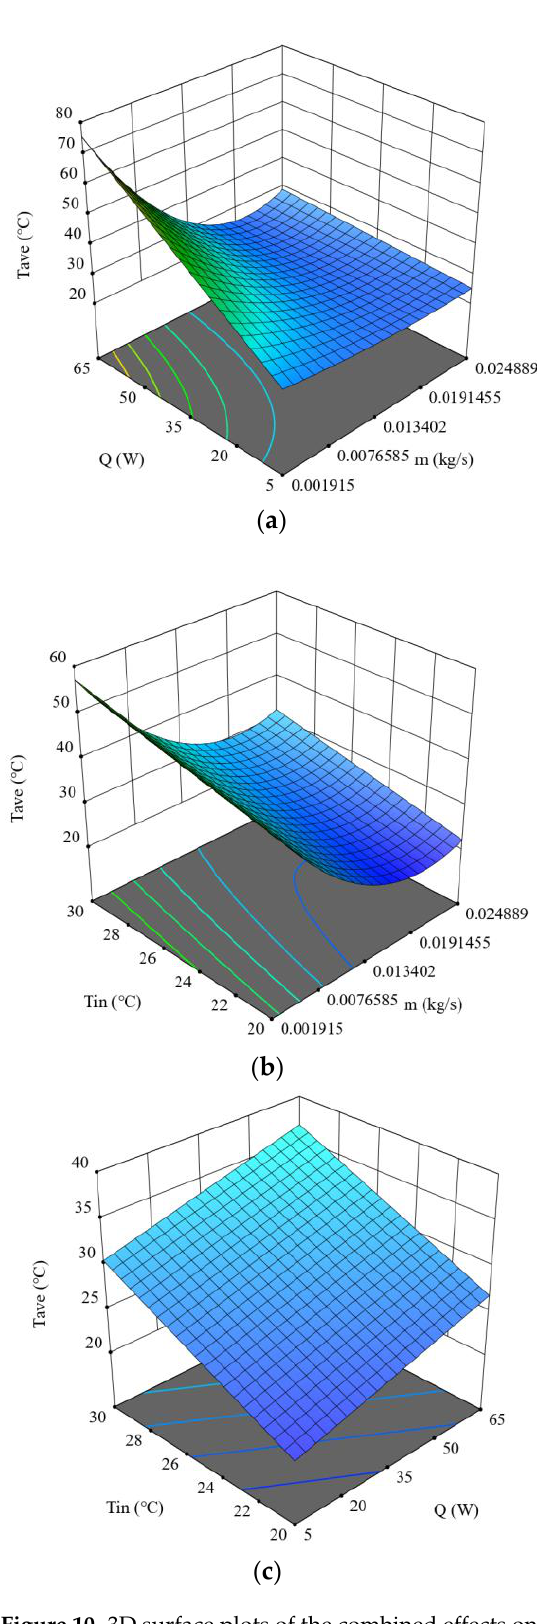
Figure 10. 3D surface plots of the combined effects on the average temperature: ( a ) Q · m ̇ ; ( b ) T in · m ̇ ; ( c ) Q · T in .